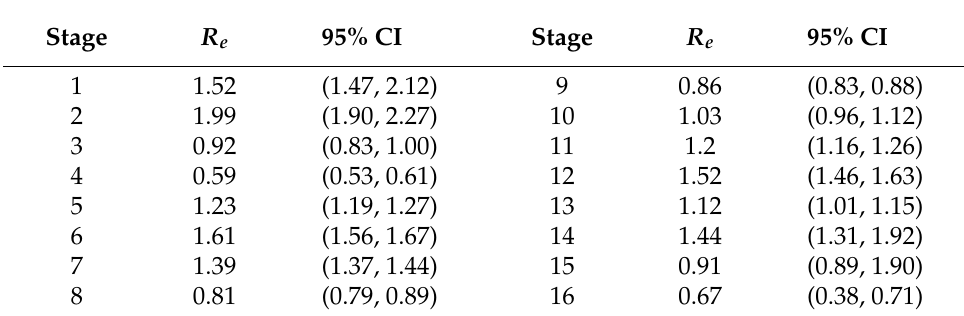
Table 3. Effective reproduction number R e determined by the